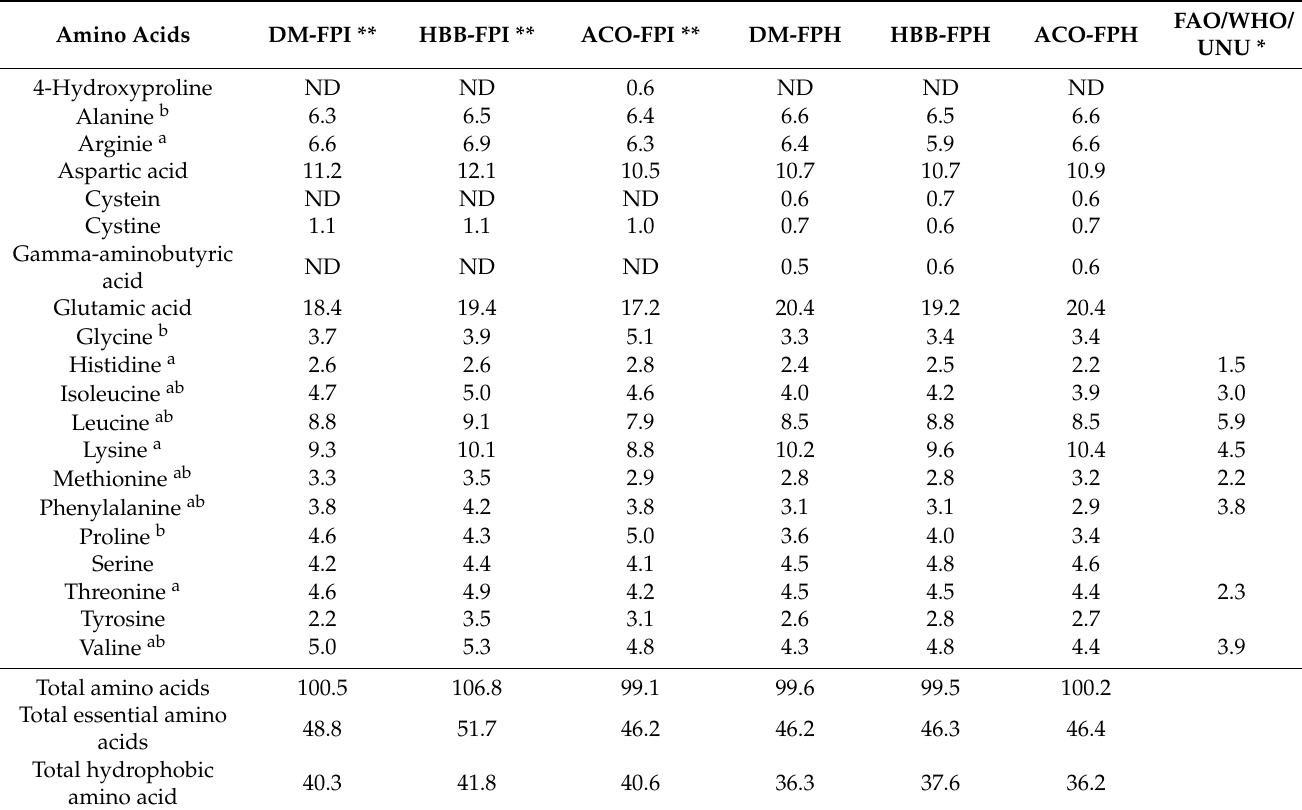
Table 2. Amino acid compositions (g/100 g protein) of the fish protein hydrolysates produced from fish protein isolates prepared from dark muscle (DM-FPH), head and backbone blend (HBB-FPH), and abdominal cut-offs (ACO-FPH).